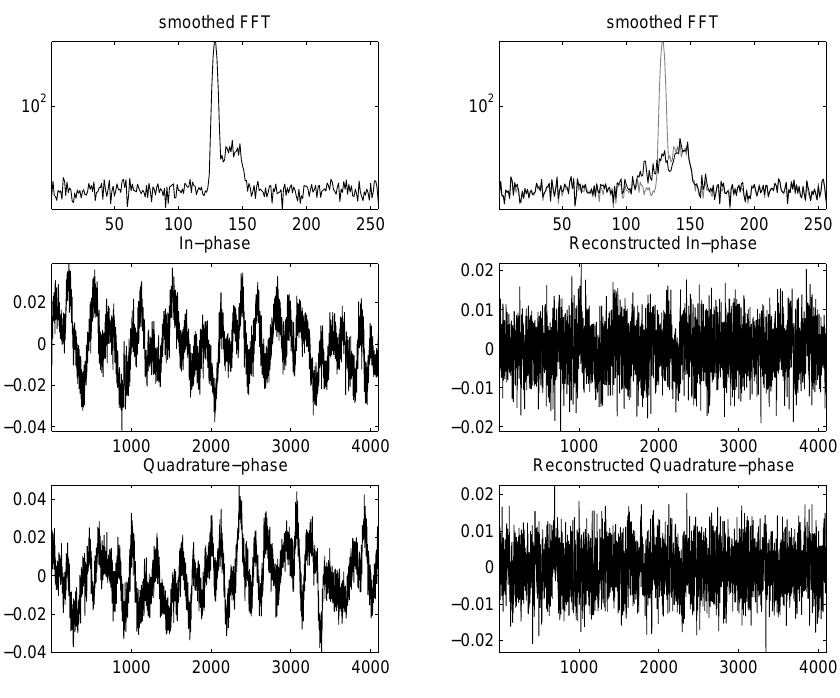
Fig. 8. Top left: Simulated Fourier- power-spectrum with strong ground clutter influence and with an atmo- spheric signal overlapping the ground clutter peak. Lower left: I/Q time se- ries derived from the simulated Fourier- power-spectrum using the Zrni´c (1975) method. Lower right: I/Q time series after applying the nonlinear wavelet fil- ter. Top right: Resulting Fourier-power- spectrum based on the reconstructed (filtered)